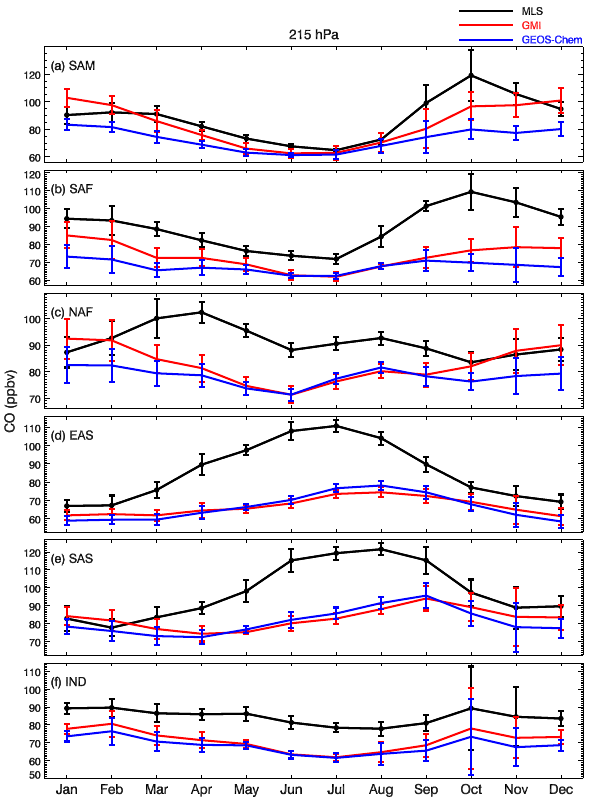
Figure 13. As in Fig. 12, but for CO mixing ratio at